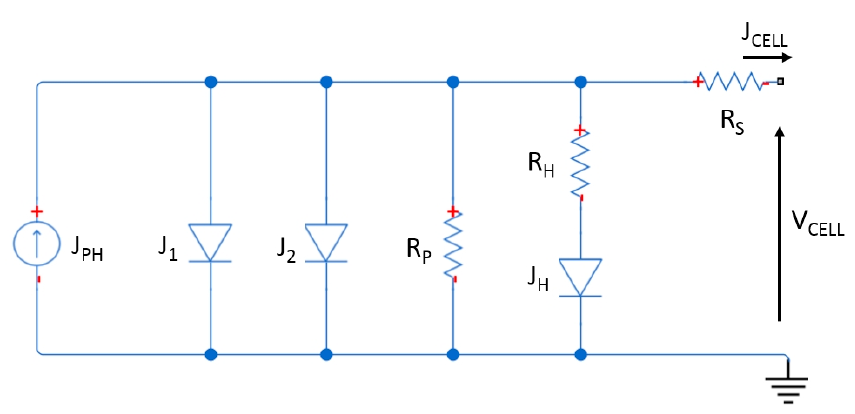
Figure 12. Circuital model of a module with a severely damaged cell.